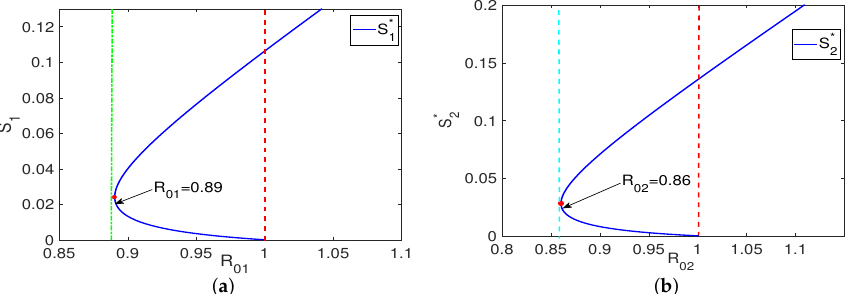
Figure 2. ( a ) The backward bifurcation graph of S ∗ backward bifurcation graph of S ∗